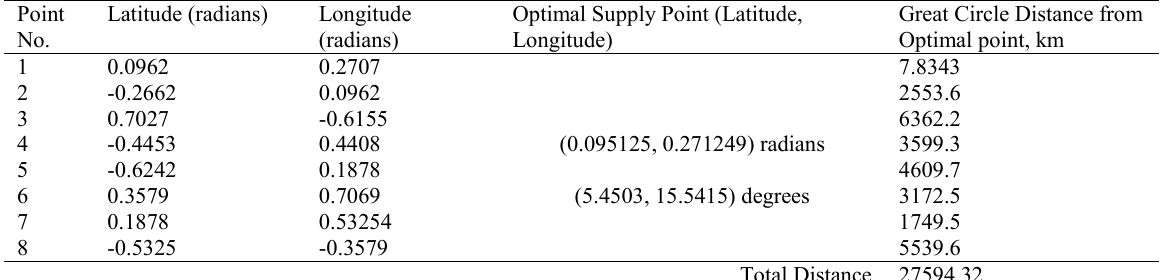
Table 2 Optimal Supply Point and Great Circle